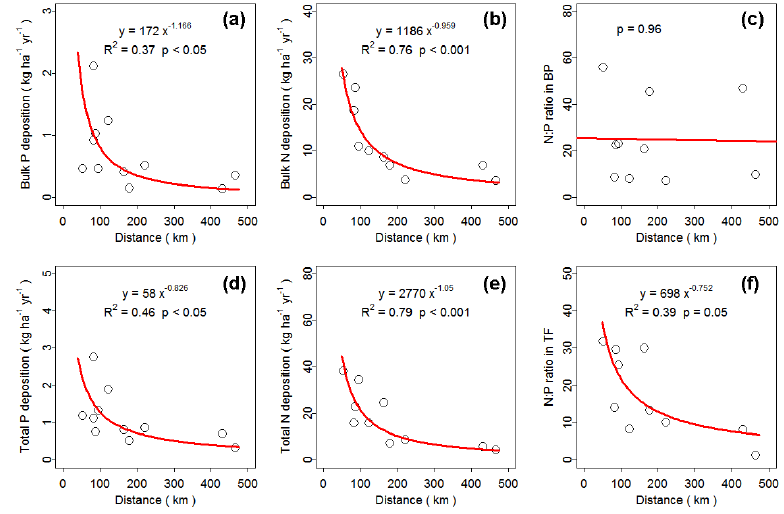
Figure 5. Changes in bulk deposition of P and N (kgha − 1 yr − 1 ) , total deposition of P and N (kgha − 1 yr − 1 ) , and N:P ratios in bulk precipitation (BP) and throughfall (TF), with the distance to the nearest large cities based on datasets of forested sites nearby semiarid regions in